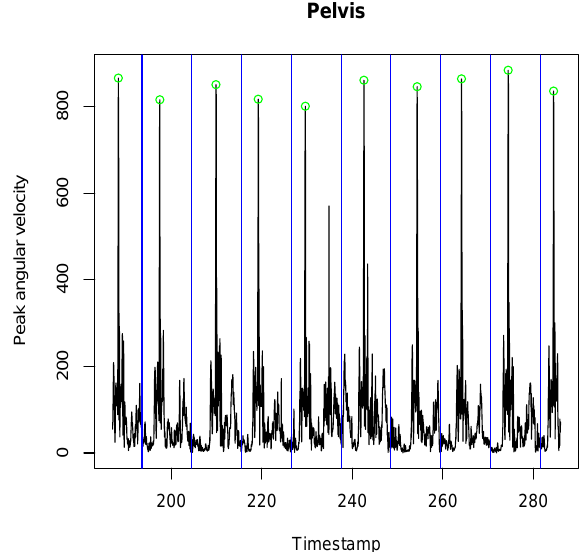
Figure 2. Segmenting the baseball pitches using gyroscope peaks. For the gyroscope signal, we calculated the peak angular velocity as its Euclidean norm. Each recording was manually segmented into parts containing only a single pitch. We performed the segmentation by plotting the entire gyroscope signal and locating the 10 peaks each corresponding to a